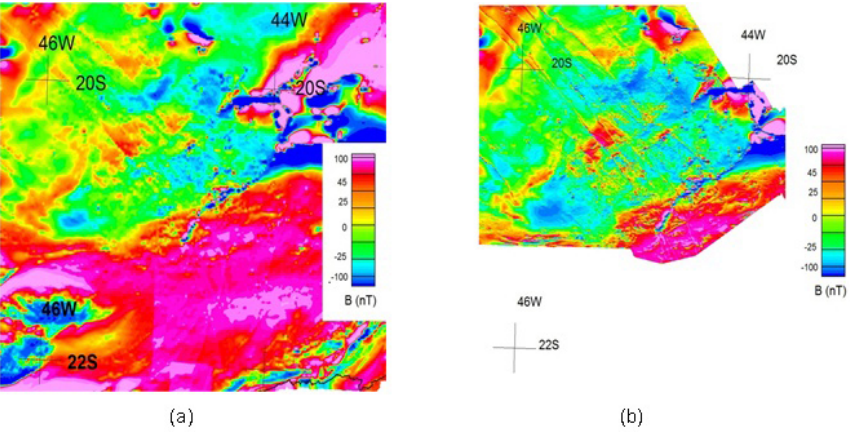
Figure 18. (a) Geophysical Brazil–Germany Project acquisition (code 1009 – CPRM, 1980) and (b) area second acquisition in 2005 (source: